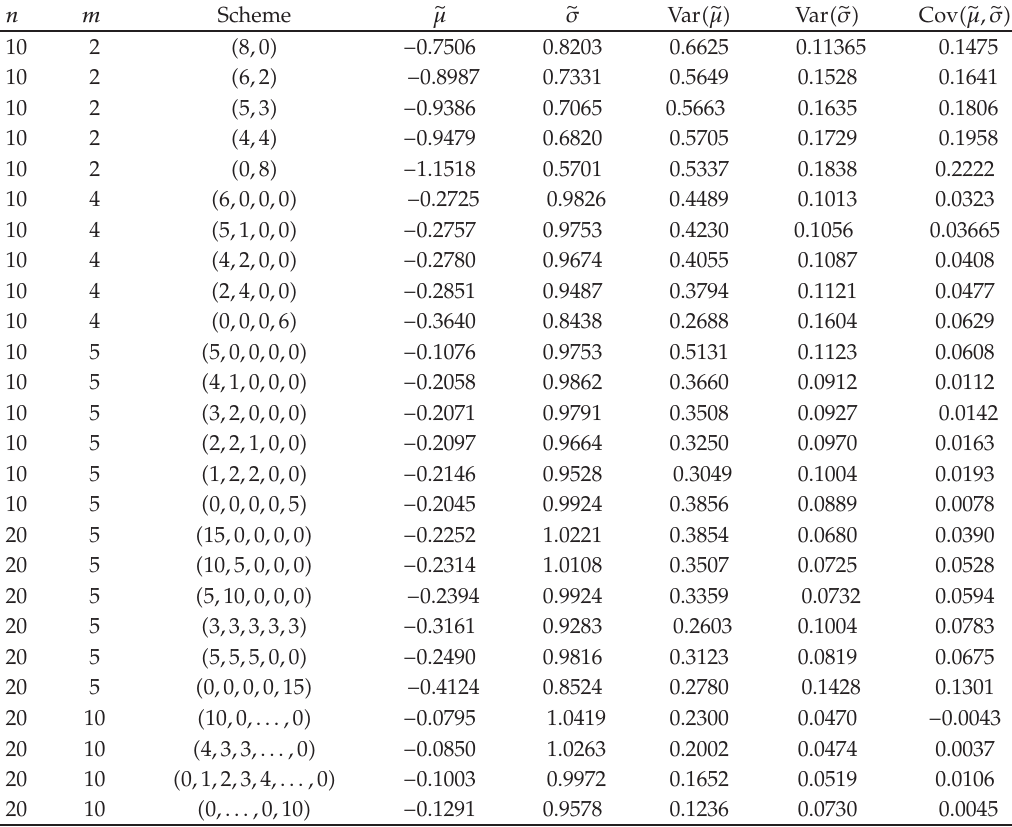
Table 5: Average, variances, and covariance of the approximate MLEs when the shape parameter φ (cid:7) 1 .